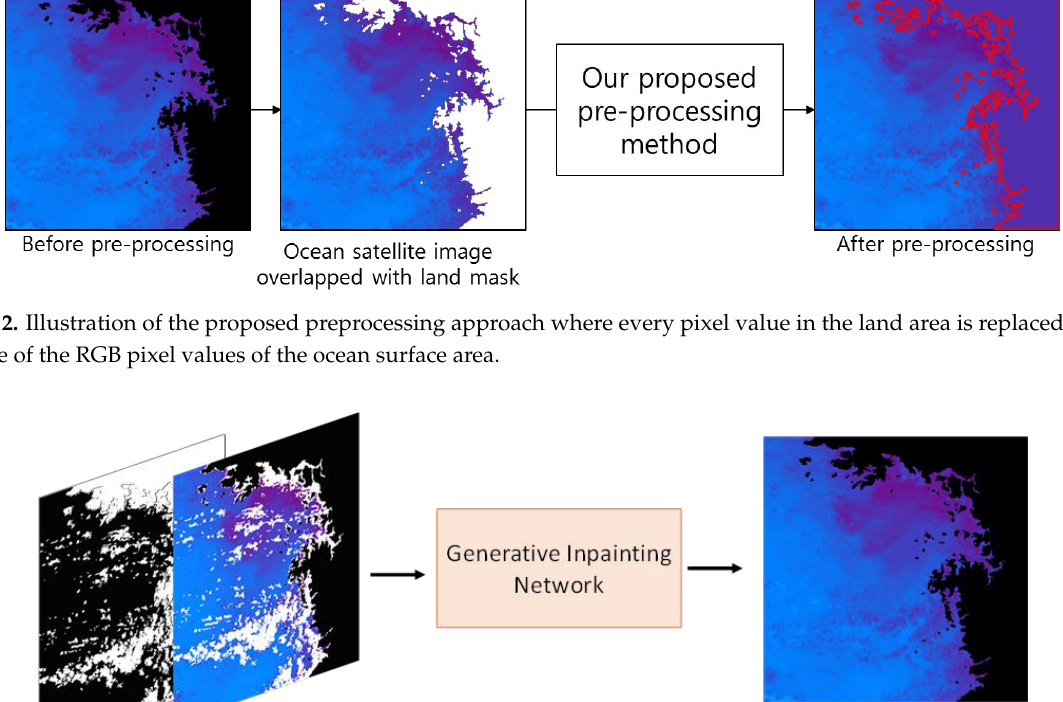
Figure 4. Overall process of constructing our generative inpainting network (GIN) to restore satellite sea surface temper- ature. It consists of a coarse network and refinement network, as well as two auxiliary discriminant networks that are used only for training the coarse and refinement networks; hence, they are not used during the testing. The coarse network takes the entire ocean satellite image as input, while the refinement network takes only a local region of the inpainted region as input. Note that the coarse network is trained with reconstruction and sea surface losses explicitly, while the refinement network is trained with adversarial GAN loss, and global and local losses with gradient penalty. For the layer implementation of our inpainting network, we used mirror padding [20] for all convolution layers and removed batch normalization layers [21], which en- courage spatial and/or color coherency. We also used Exponential Linear Units (ELUs) [22,23] as activation functions and clipped the output filter values. Our GIN is trained end-to-end with the adversarial GAN loss, reconstruction loss, and three Wasserstein GAN losses, two of which account for the global image while one accounts for the local patch of the missing regions. This allows for the use of both global and local feature rep- resentations for GIN training. 2.3. Loss Function To implement the proposed GIN model, we developed a modified version of the Wasserstein GAN (WGAN) [24] with a gradient penalty. To train the GIN, we attached the WGAN loss to both global and local outputs of the second-stage refinement network to enhance the consistency of global and local regions of reconstructed ocean satellite im- ages via image inpainting. Reference [24] reports that the WGAN loss outperforms gen- eral GAN losses for image generation tasks, and it also works well when combined with